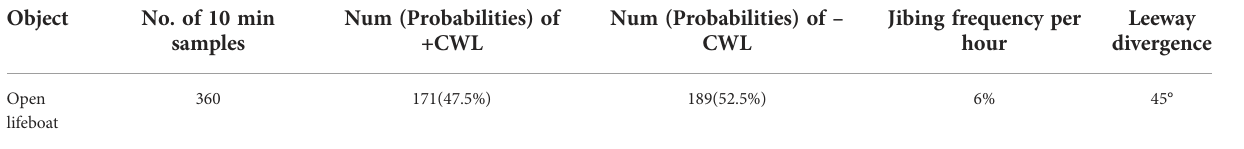
TABLE 3 Statistics on the quantity of crosswinds, the frequency of jibing, and the leeway divergence. Object